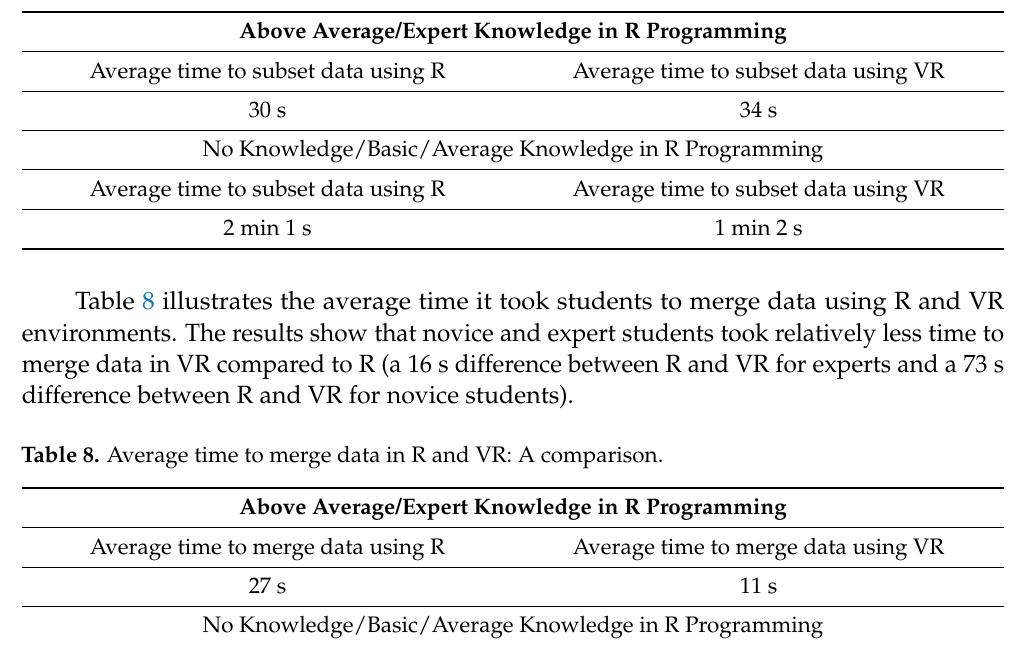
Table 7. Average time to subset data in R and VR: A comparison.